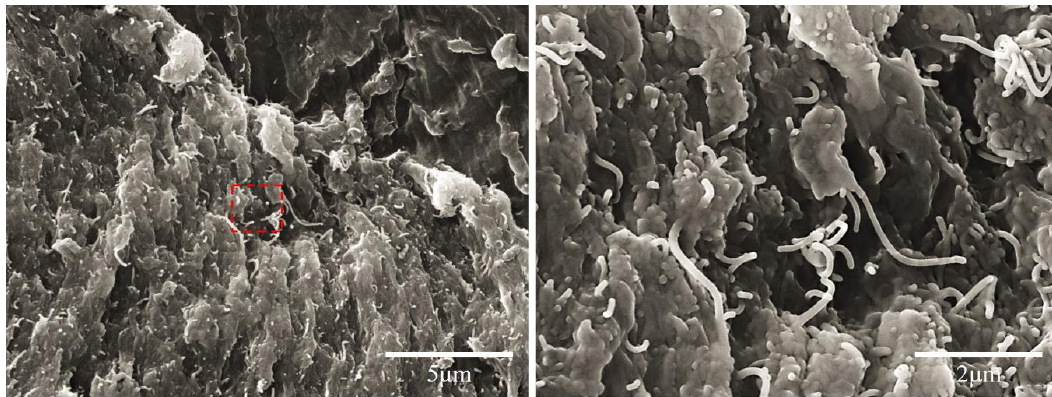
Figure 1. Water contact angle of CNT/PU coatings with 1 wt.% (left) and 7 wt.% (right) CNTs.